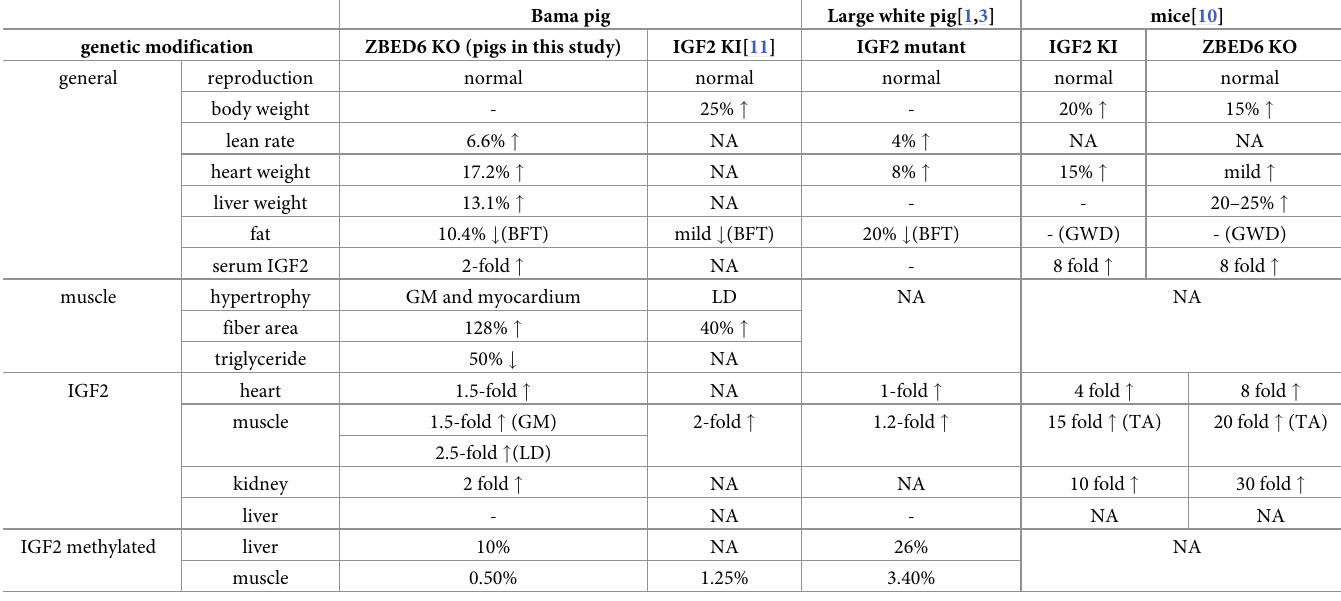
BFT: back fat thickness, GWD: gonadal white adipose, TAW: tibialis anterior weight, GM: gastrocnemius